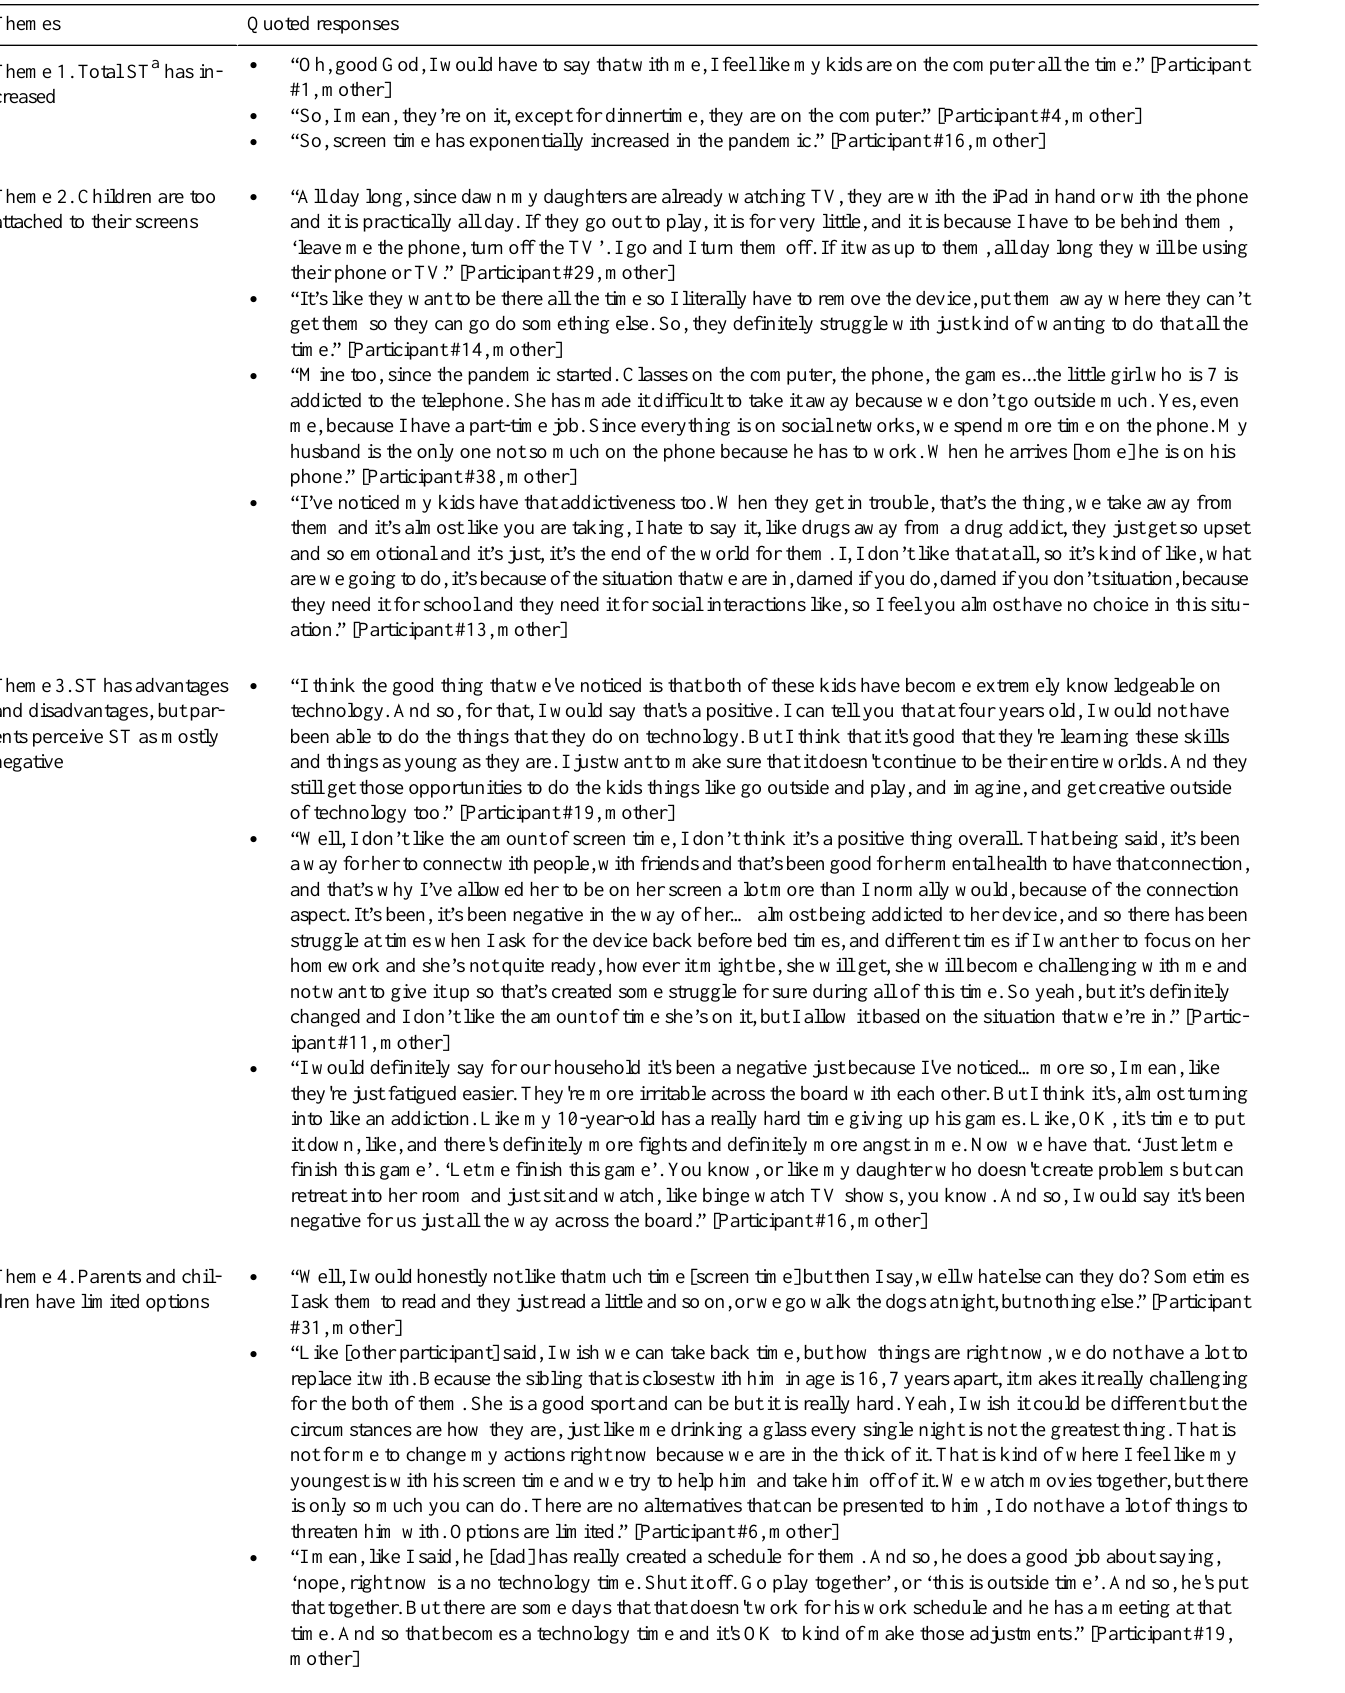
Table 2. Themes and representative quotes.